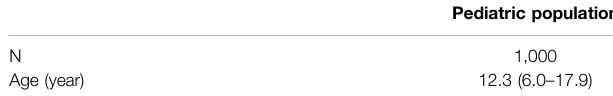
TABLE 4 | Demographic data in virtual pediatric population. TABLE 5 | Dosing regimen for TQ-B3101 in virtual pediatric population 6-